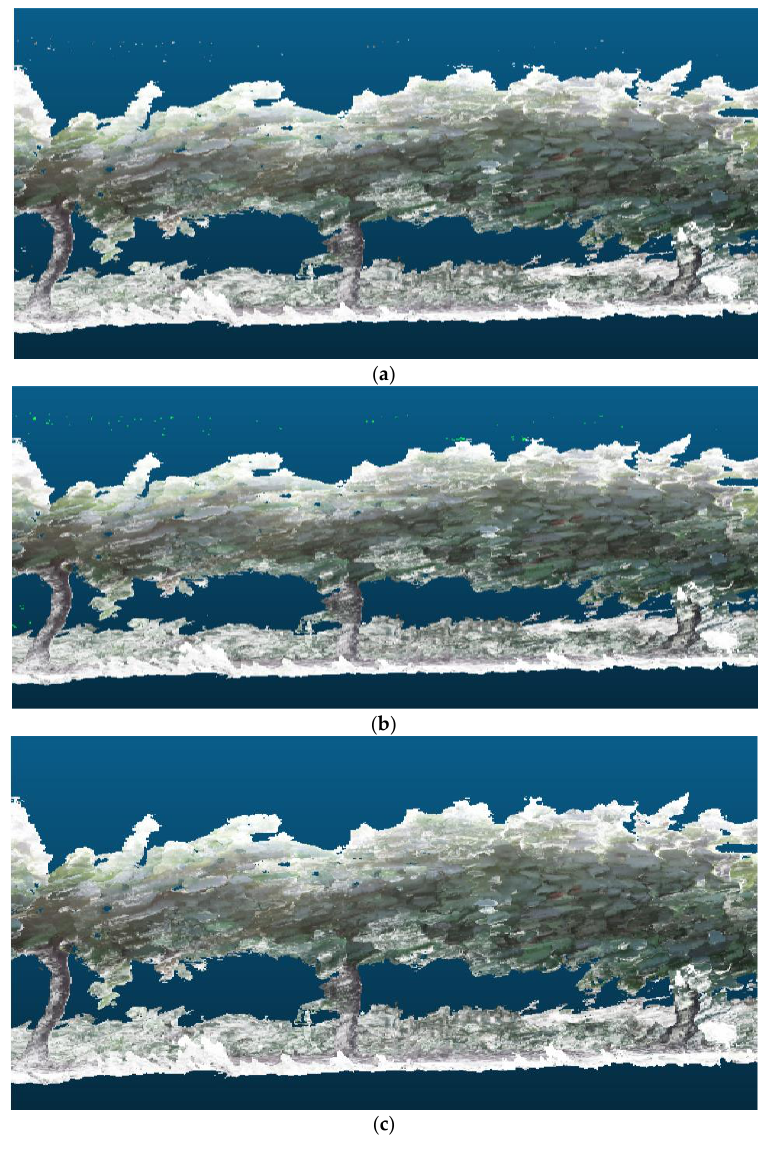
Figure 3. Section of the 3D reconstruction of a vineyard row: before filtering ( a ); and after filtering ( c ). The removed points are marked in fluorescent green in image ( b ).